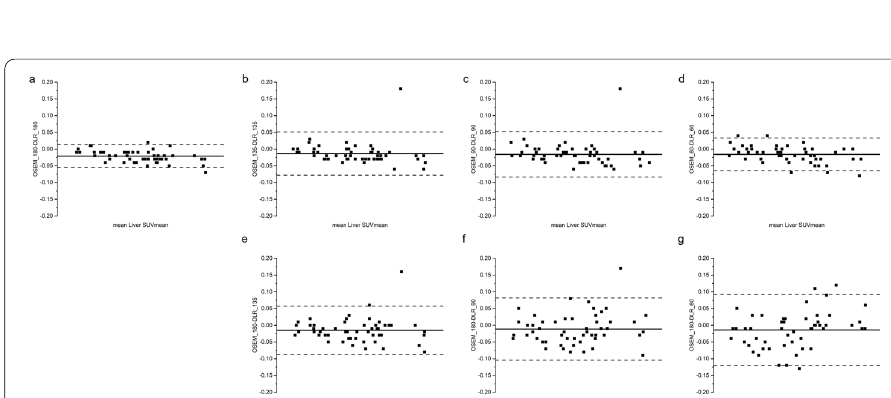
Fig. 5 Characteristics of the identified lesions ( n tomography images. Right: SUVmax of the lesions measured in the reference GS_180 PET images. SUV, standardized uptake value